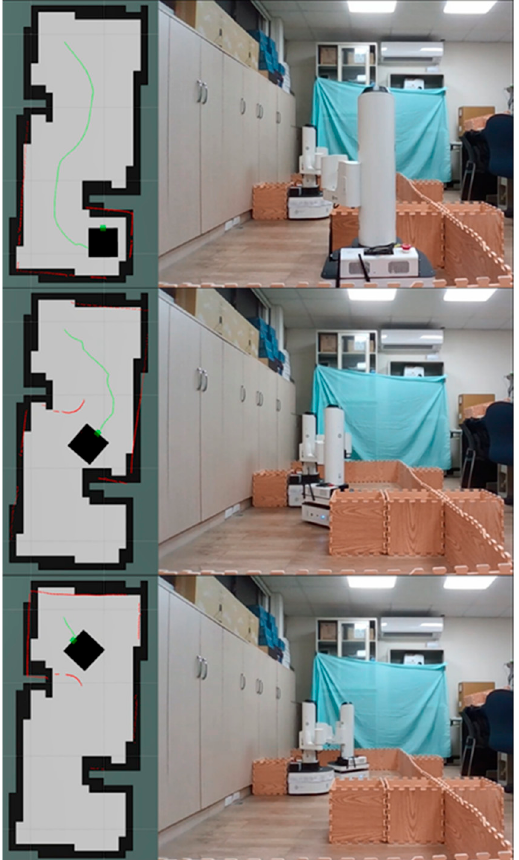
Figure 13. The path planning result in the environment with an unknown fixed obstacle.